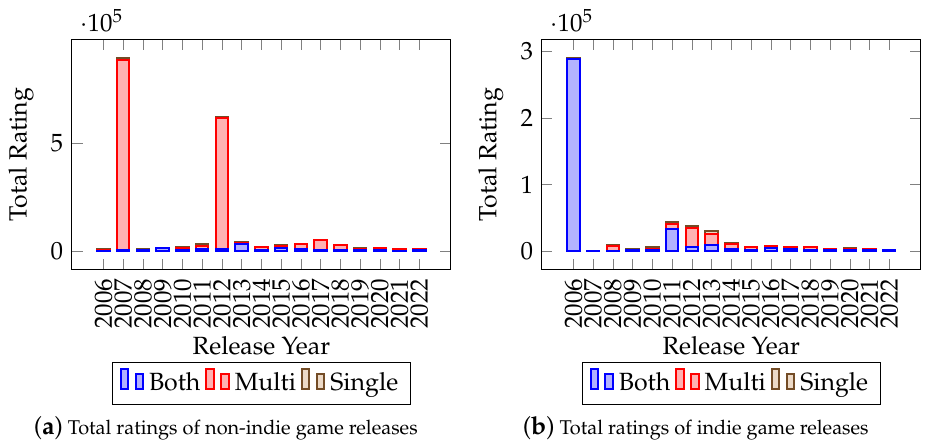
Figure 7. Players’ ratings of game types released over the year for ( a ) non-indie games and ( b ) in- die